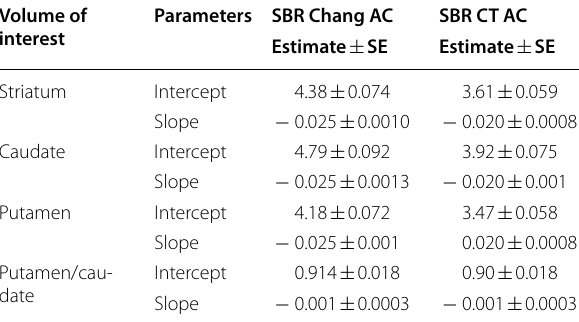
Table 2 linear regression between Specific Binding Ratio according to attenuation correction methods and age